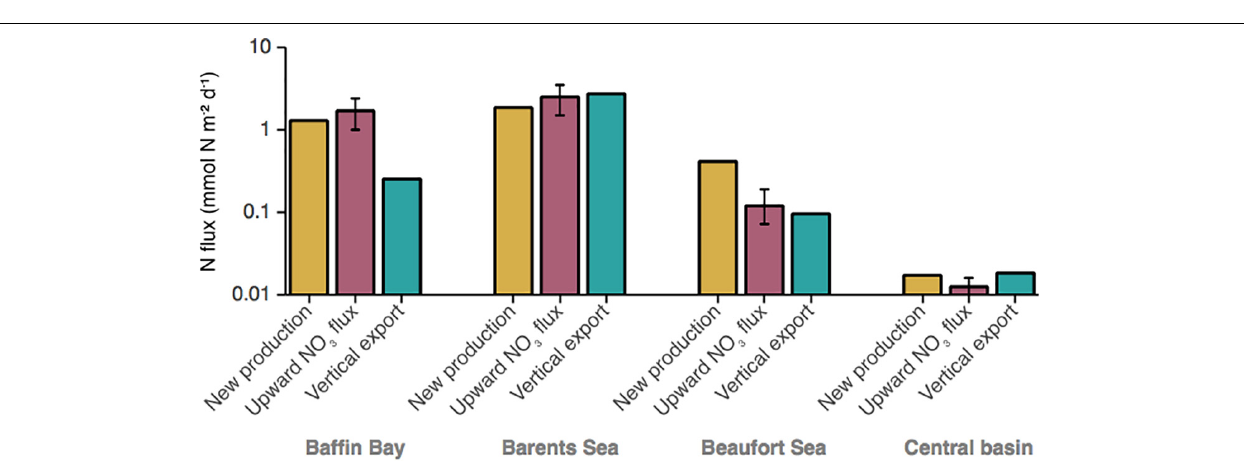
Frontiers in Marine Science |